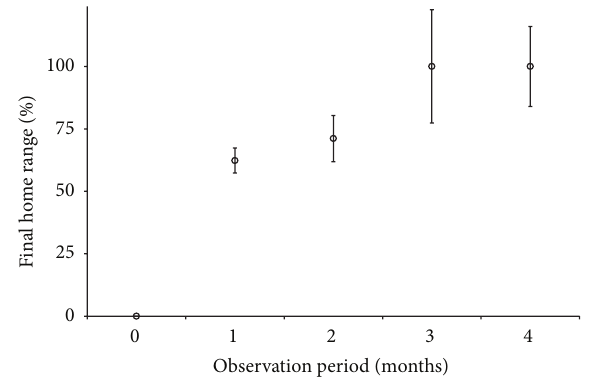
Figure 5: Least squares mean estimates from mixed model regres- sion of percent of final minimum convex polygon (MCP) home range attained versus months of observation for red grouper. Bars denote standard